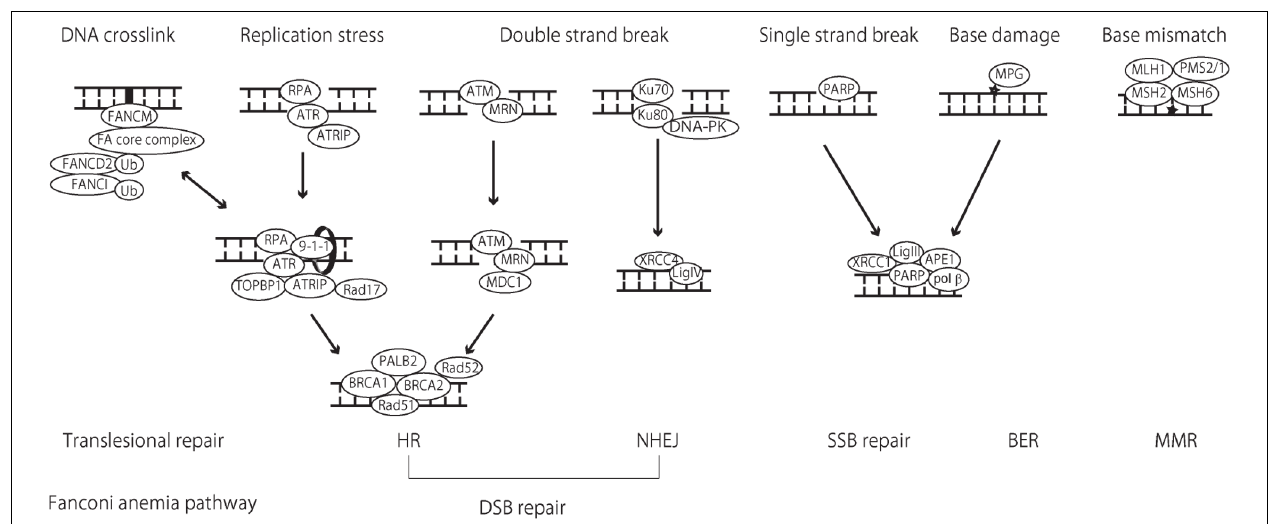
FIGURE 2 | Schematic illustration of DNA repair pathways and implicated proteins. Mismatch repair (MMR) functions in the repair of base substitution mutations as well as small insertions/deletions caused by replication errors.The heterodimeric complex of MSH2 and MSH6 recognizes base mismatches and single-base insertions/deletions, whereas the MSH2 and MSH6 complex (not described in this schema) detect larger insertions/deletions.These complexes recruit another heterodimeric complex made up of MLH1 and PMS2 to initiate the repair process by excision of mismatches and insertions/deletions and re-synthesis of the DNA strand. In base excision repair (BER), a damaged base is recognized by a DNA glycosylase enzyme. Of all DNA glycosylase, DNA glycosylase (MPG) [alkylpurine-DNA- N -glycosylase (APNG)] recognizes and removes alkylated bases before apurinic/apyrimidinic endonuclease 1 (APE1) recognizes the abasic sites and cleaves the 5 (cid:2) end of the DNA. In the major BER pathway, as a short-patch pathway, DNA polymerase β (poly β ) excises the 3 (cid:2) end of the DNA and fills the gap. Finally, the XRCC1-ligase III complex catalyzes the formation of phosphodiester bonds and completes the repair process. Poly (ADP-ribose) polymerase (PARP) recognizes single-strand breaks and initiates the repair process in an overlapping manner with BER. For DSB repair, non-homologous end-joining (NHEJ) and homologous recombination (HR) are utilized in the repair mechanism. In NHEJ, DSB are recognized by the Ku70/80 proteins, which bind and activate the protein kinase DNA-PKcs, recruiting XRCC4 and DNA ligase IV (Lig IV) to seal the gap. In HR,